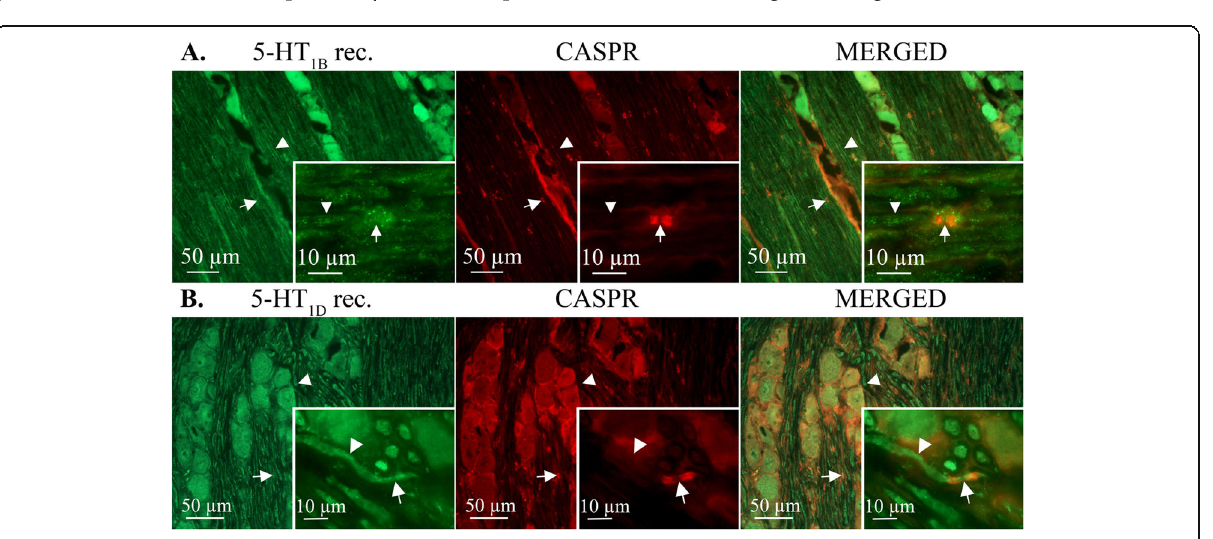
Fig. 5 Immunolocalization of 5-HT 1B and 5-HT 1D receptors in the TG. Green positive immunofluorescence for 5-HT 1B ( a ) and 5-HT 1D ( b ) receptors throughout the A δ -fiber, also at the node of Ranvier (monoclonal CASPR, red, arrow) No clear co-localization with CASPR was detected. Arrowheads point out immunopositive axons for both receptors